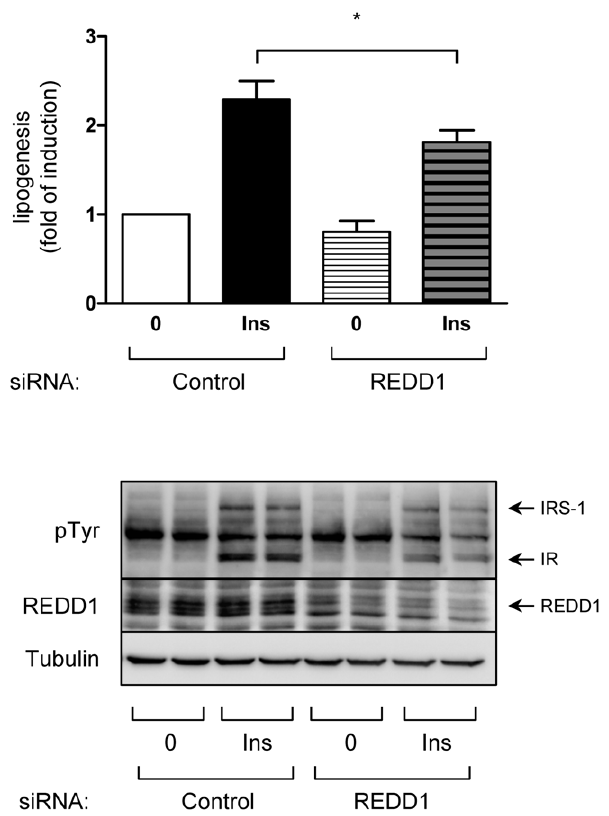
Figure 7. Downregulation of REDD1 expression inhibits lipogenesis in 3T3-L1 adipocytes. 3T3-L1 adipocytes were trans- fected with REDD1 siRNA. 48 h after transfection, 3T3-L1 adipocytes were incubated with [ 3 H] sodium acetate (0.4 mmol/l, 0.5 m Ci/ml) in absence or in presence of insulin 1 nM for 1 hour at 37 u C. Radioactivity incorporated in cellular lipids was determined in a liquid scintillation counter. Results are expressed as fold of induction of pmol of acetate/ mg of proteins (n=3, *p , 0.05). Proteins were analyzed by immuno- blots using indicated antibodies.